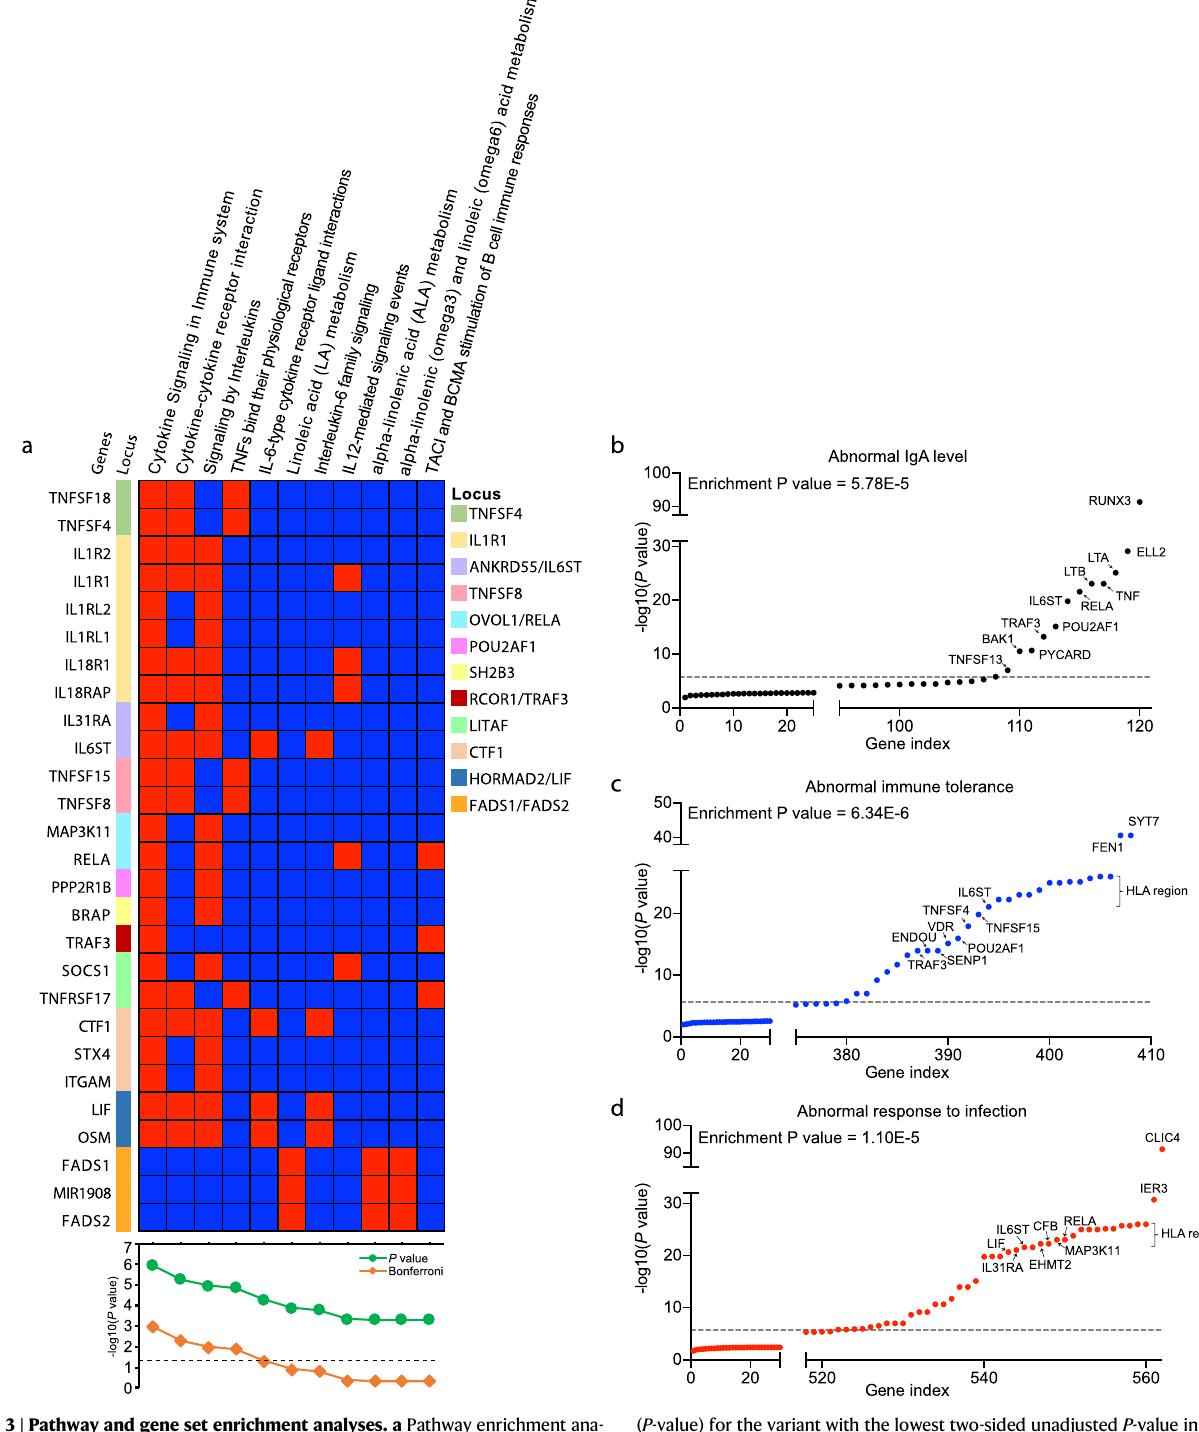
( P -value) for the variant with the lowest two-sided unadjusted P -value in each candidate gene. The dashed line corresponds to genome-wide signi fi cance (P = 5 × 10 − 8 ).Enrichment P -valuecorrespondstothetwo-sidedFisherexacttestcomparing the observed number of genes with association signals below the genome-wide threshold against the number expected under binomial